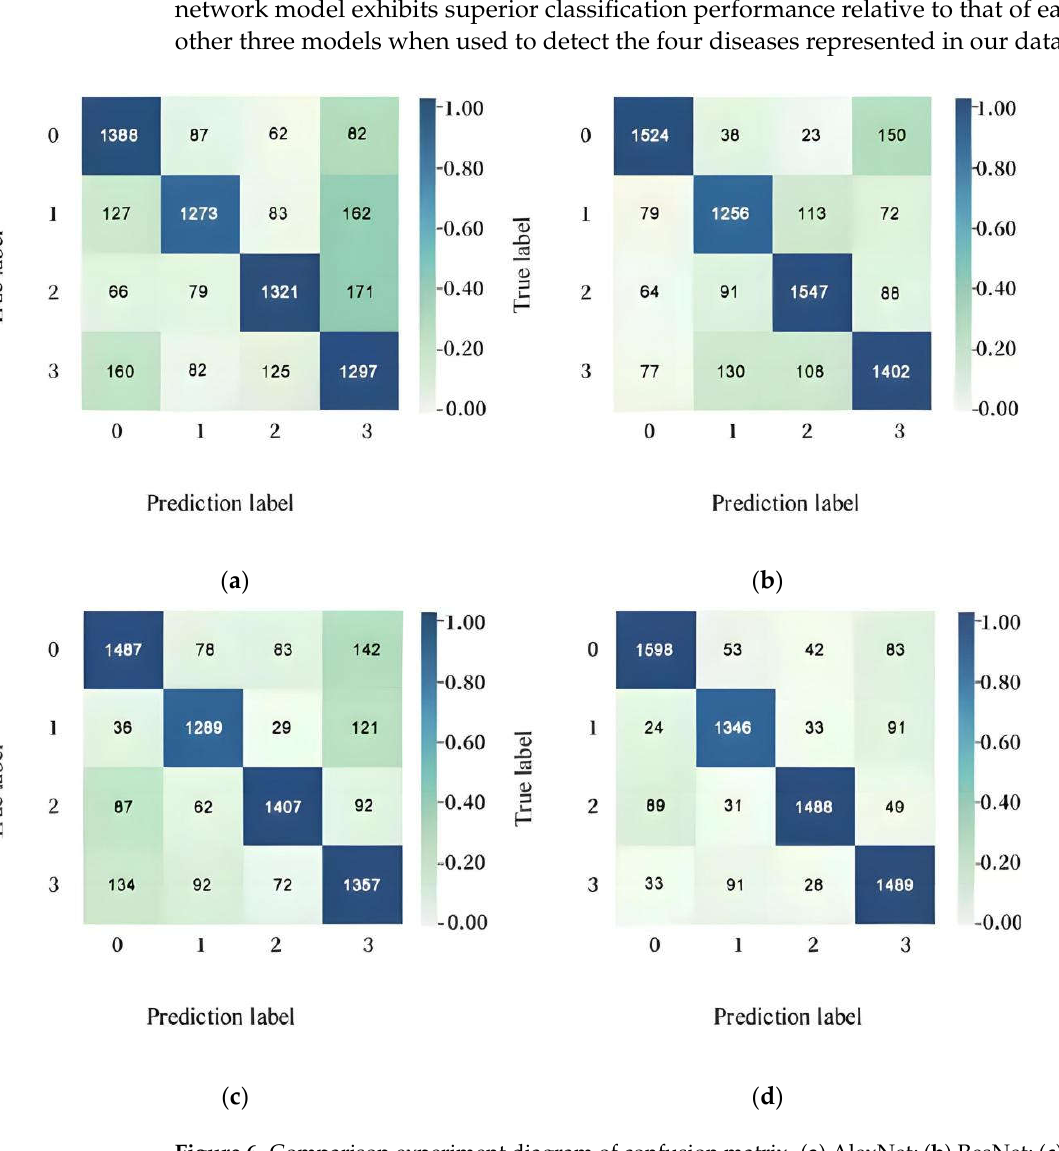
Table 5. Ablation experiment.